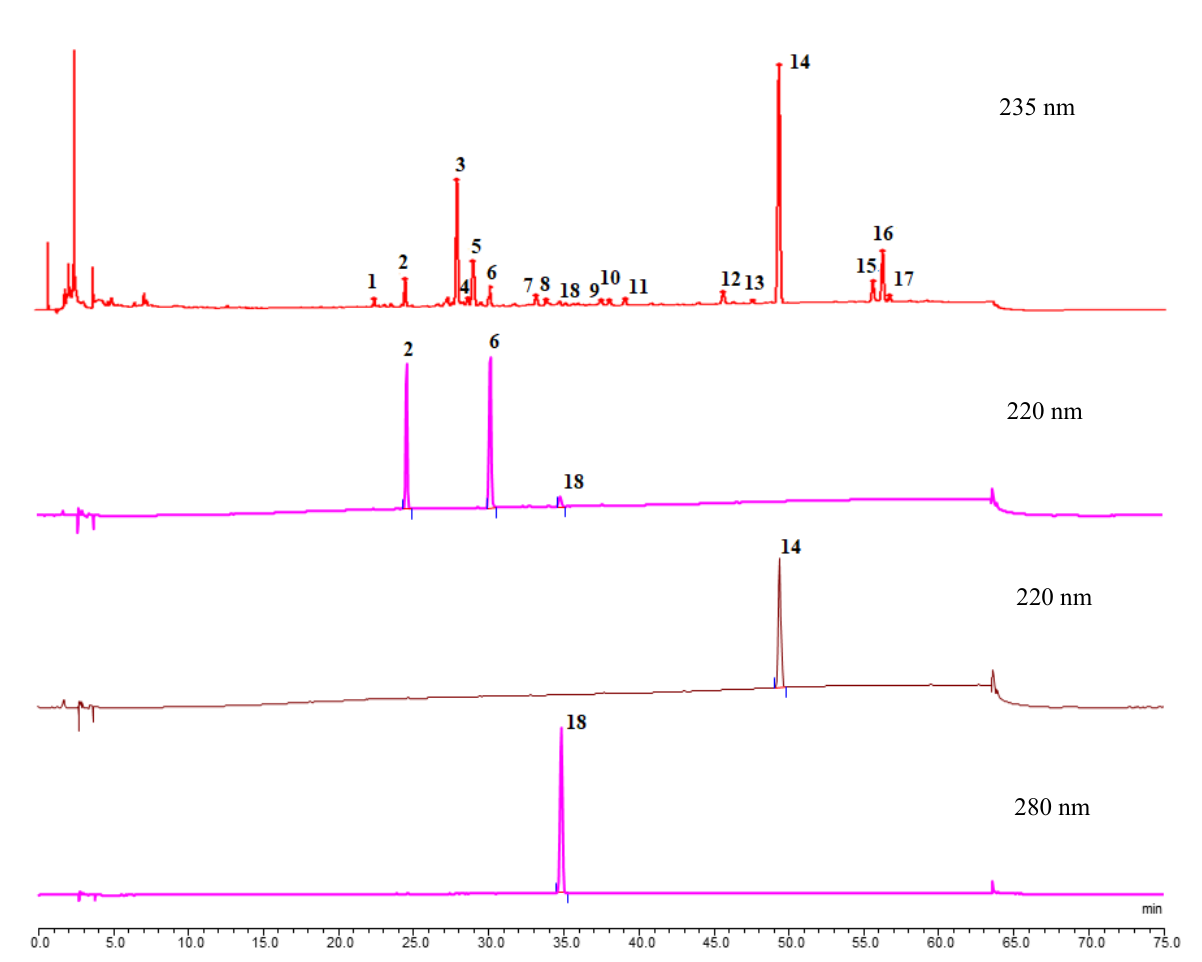
Figure 1. HPLC chromatogram reference fingerprint of AMR (235 nm). The identified peaks of fingerprints were in the order of atractylenolide III (2) (220 nm), atractylenolide II (6) (220 nm), atractylenolide I (18) (280 nm), atractylone (14) (220 nm). Table 1. The precision, repeatability, and stability of the common peaks in AMR.